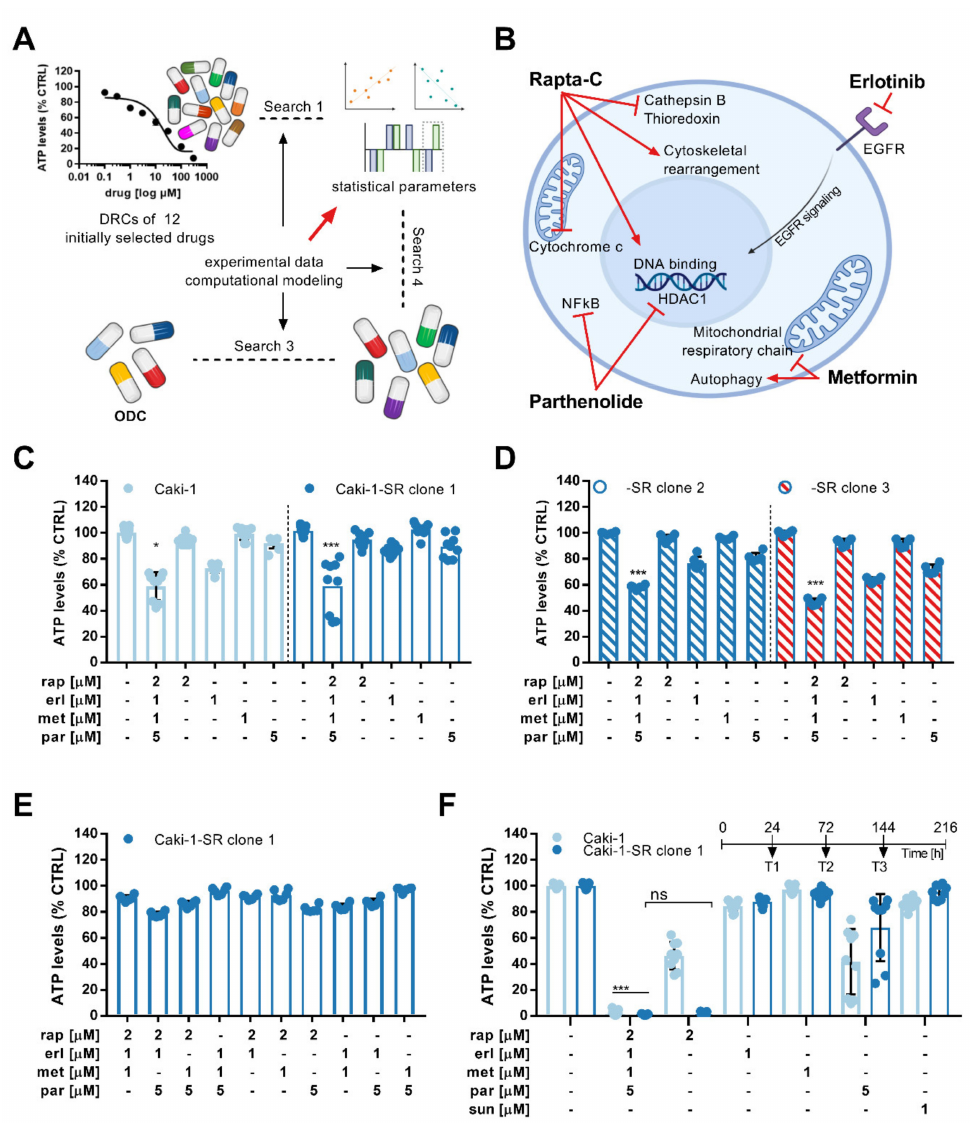
Figure 1. Optimization of a multidrug combination and its activity in 2D cell cultures. ( A ) Schematic representation of the Therapeutically Guided Multidrug Optimization method to screen for multidrug combinations. An initial set of 12 drugs was selected and drug-response curves (DRCs) were generated to visualize the single-drug effects. In three searches, experimental and computational modeling were used to generate data facilitating the calculation of statistical parameters which are needed to guide drug inclusion and exclusion between the searches. Following this iterative process, a four-drug combination was designed and optimized (ODC). ( B ) This ODC contains Rapta-C, erlotinib, metformin and parthenolide (ODC REMP ). The known targets for ODC REMP drugs are presented in the schematic of a cancer cell. ( C )